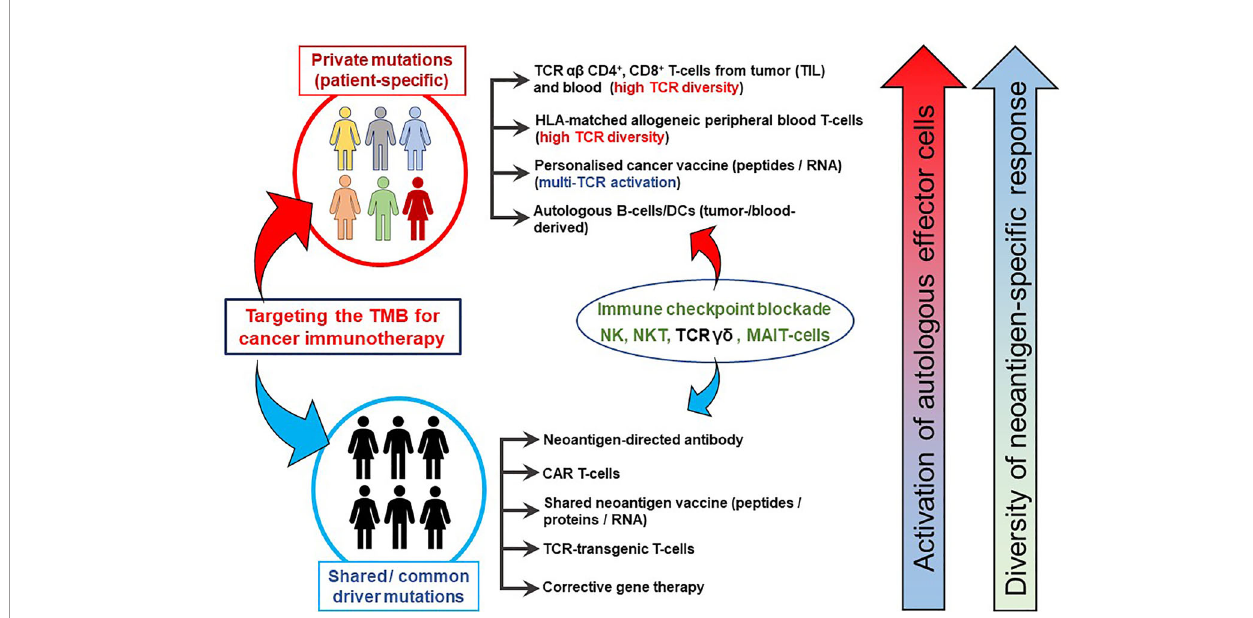
FIGURE 2 | TMB-directed immunotherapy approaches at the Champalimaud Centre for the Unknown. The schematic shows strategies aimed at therapeutic targeting of private (personalized and patient-speci fi c) and shared (often driver) mutations. For personalized therapy, CD4 + and CD8 + T-cells from TIL or peripheral blood expressing a highly diverse TCR ab repertoire recognizing a private neoepitopes can be procured. HLA-matched, healthy donor-derived TCRs have also been shown to recognize patient-speci fi c neoepitopes (21). Personalized cancer vaccines, comprising private neoepitopes as a peptide formulation or as RNA constructs, promote durable immune responses in patients with advanced cancer. Autologous B-cells can be used as a source of APCs as well as cytokine producers, in addition to their differentiation into plasma cells to secrete tumor antigen-speci fi c antibodies in vivo . Approaches targeting shared mutations serve as excellent ‘ off- the-shelf ’ options which can be used for larger groups of patients simultaneously. Cancer vaccines based on shared mutations are also clinically important, provided the patients ’ HLA pro fi les are matched to the epitope binding characteristics. Antibodies derived from tumor-in fi ltrating B-cells or from peripheral blood B-cells targeting surface-bound shared neoantigens may mediating cellular cytotoxicity and aid in the development of CAR T-cells. Gene therapy to correct shared driver mutations may promote tumor susceptibility to immune attack. Immune checkpoint blockade has been placed between the two domains as its clinical activity targets both private and shared mutated targets. Similarly, NK, TCR gd T-cells and possibly NKT T-cells or MAIT-cells may be instrumental in patients presenting with private and/or shared HLA pathway mutations and can be derived from allogeneic sources for